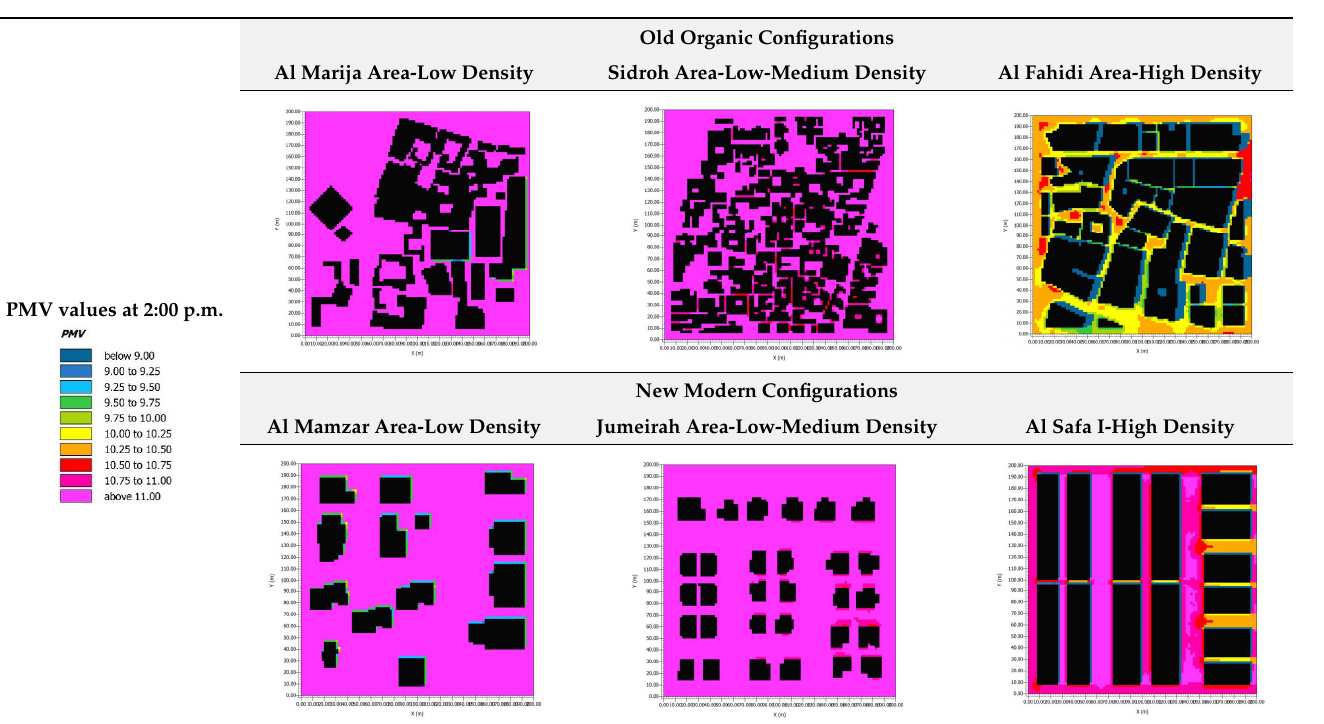
PMV values at 2:00 p.m.